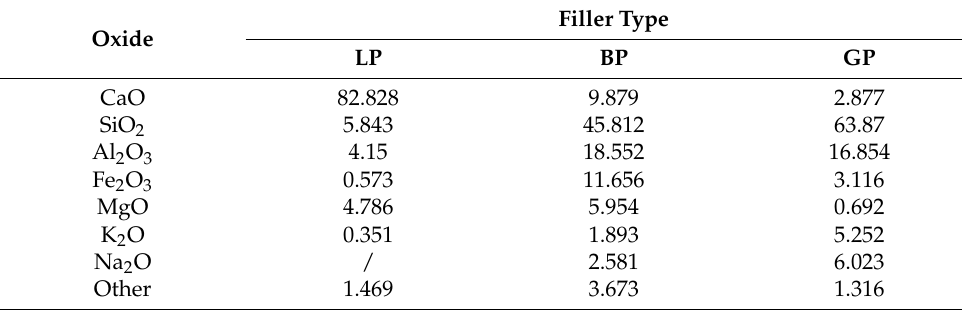
Table 4. Oxide composition of mineral fillers (%).